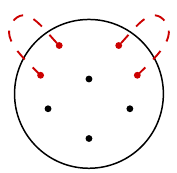
Figure 7 . Sphere with two